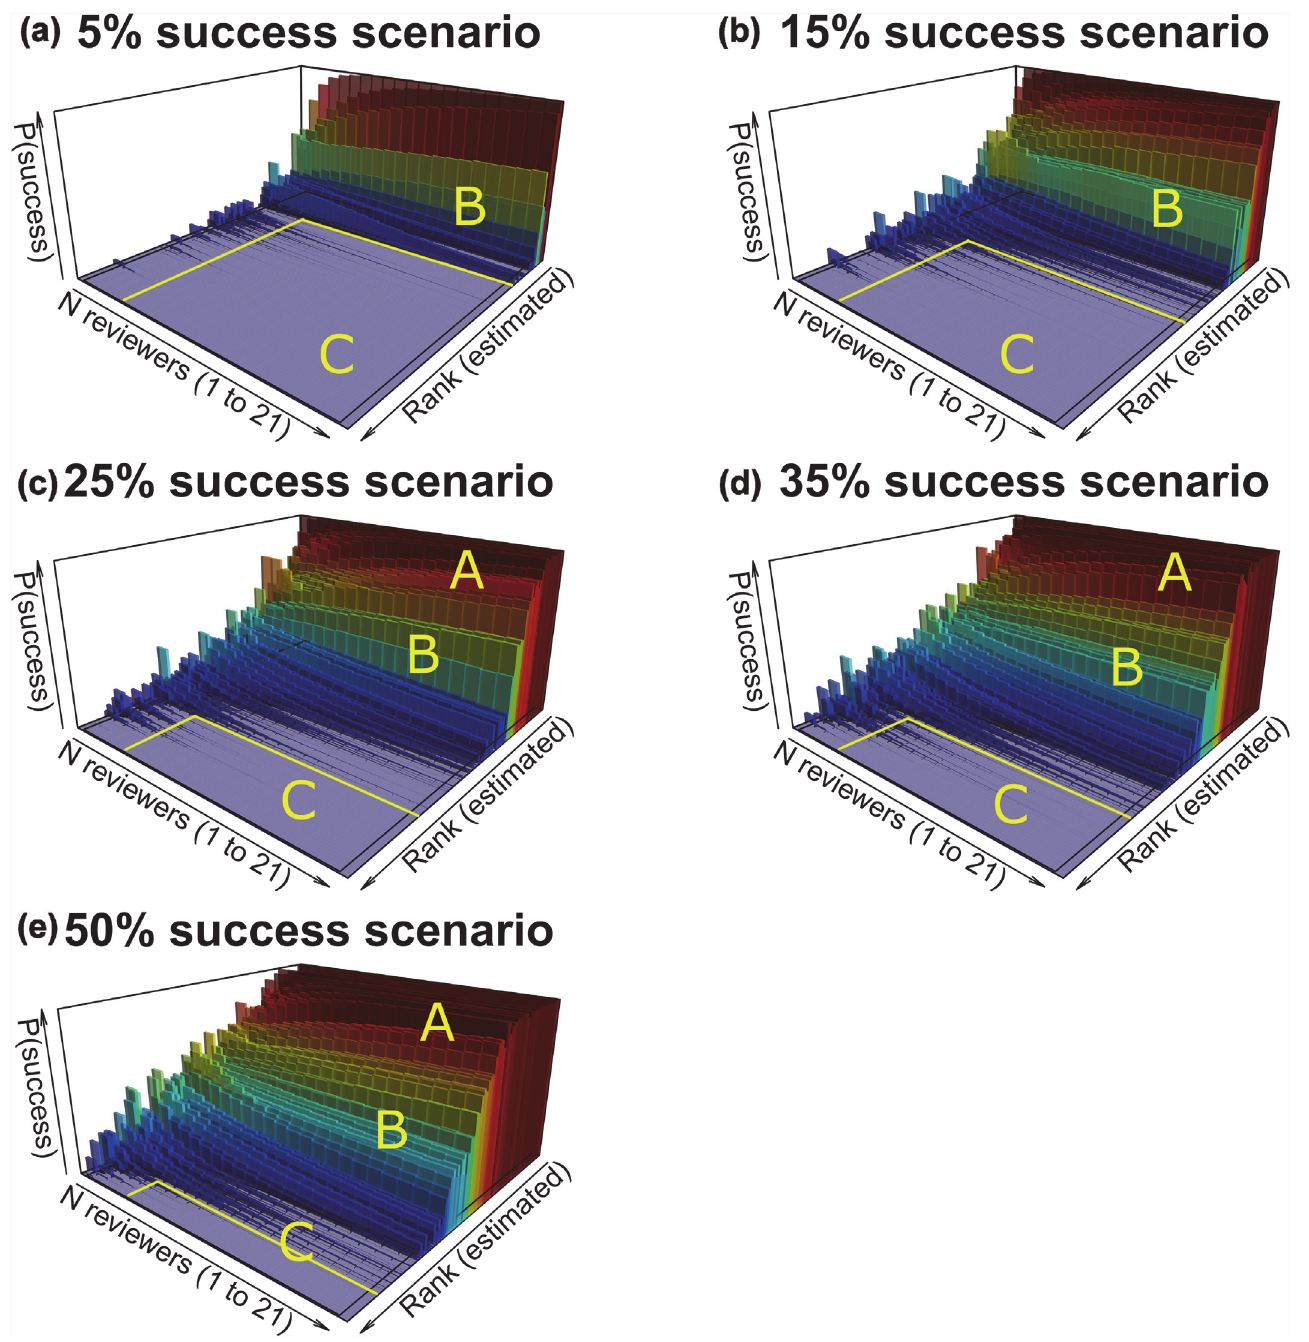
Fig 2. Funding success probability profiles in five overall competition scenarios (1 to 21 reviewers per application). Cumulative sum of 10,000 bootstrapped simulations of competition outcomes, for 100 applications within five overall success scenarios [5% (a), 15% (b), 25% (c), 35% (d), and 50% (e)]. Within some scenarios, the most competitive applications had (cid:1) ~95% probability of success (Category A). Applications of intermediate competitiveness (Category B) had a probability of success which varied from ~5% to ~95%. The least competitive applications (Category C) were rarely ( (cid:3) ~5% probability) or never